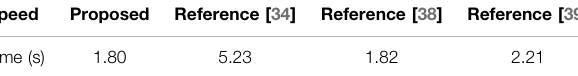
TABLE 9 | Running time compared to the relevant encryption systems (unit: